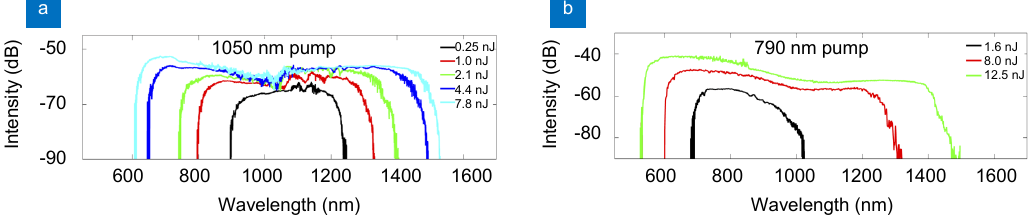
Fig. 4 | Spectra of supercontinuum generation by pumping PCF A in different pulse energy . ( a ) Central pump wavelength at 1050 nm. ( b ) Central pump wavelength at 790 nm. Figure reproduced from ref. 20 , Optical Society of America.